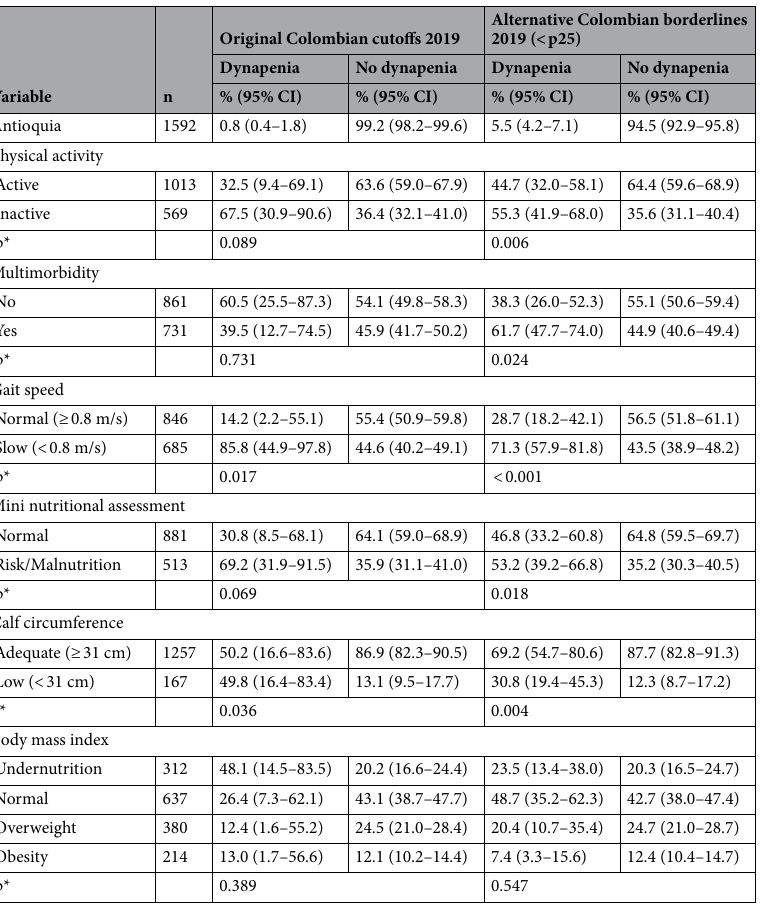
Table 3. Health, functionality, and anthropometrics characteristics according to dynapenia by Colombian proposal. Original Colombian cutoffs 2019: reference cutoffs for handgrip strength among older adults 17 . Alternative Colombian borderlines 2019 (< p25): values lower than the 25-percentile taken from Ramirez- Velez et al. 17 . *Maximum likelihood